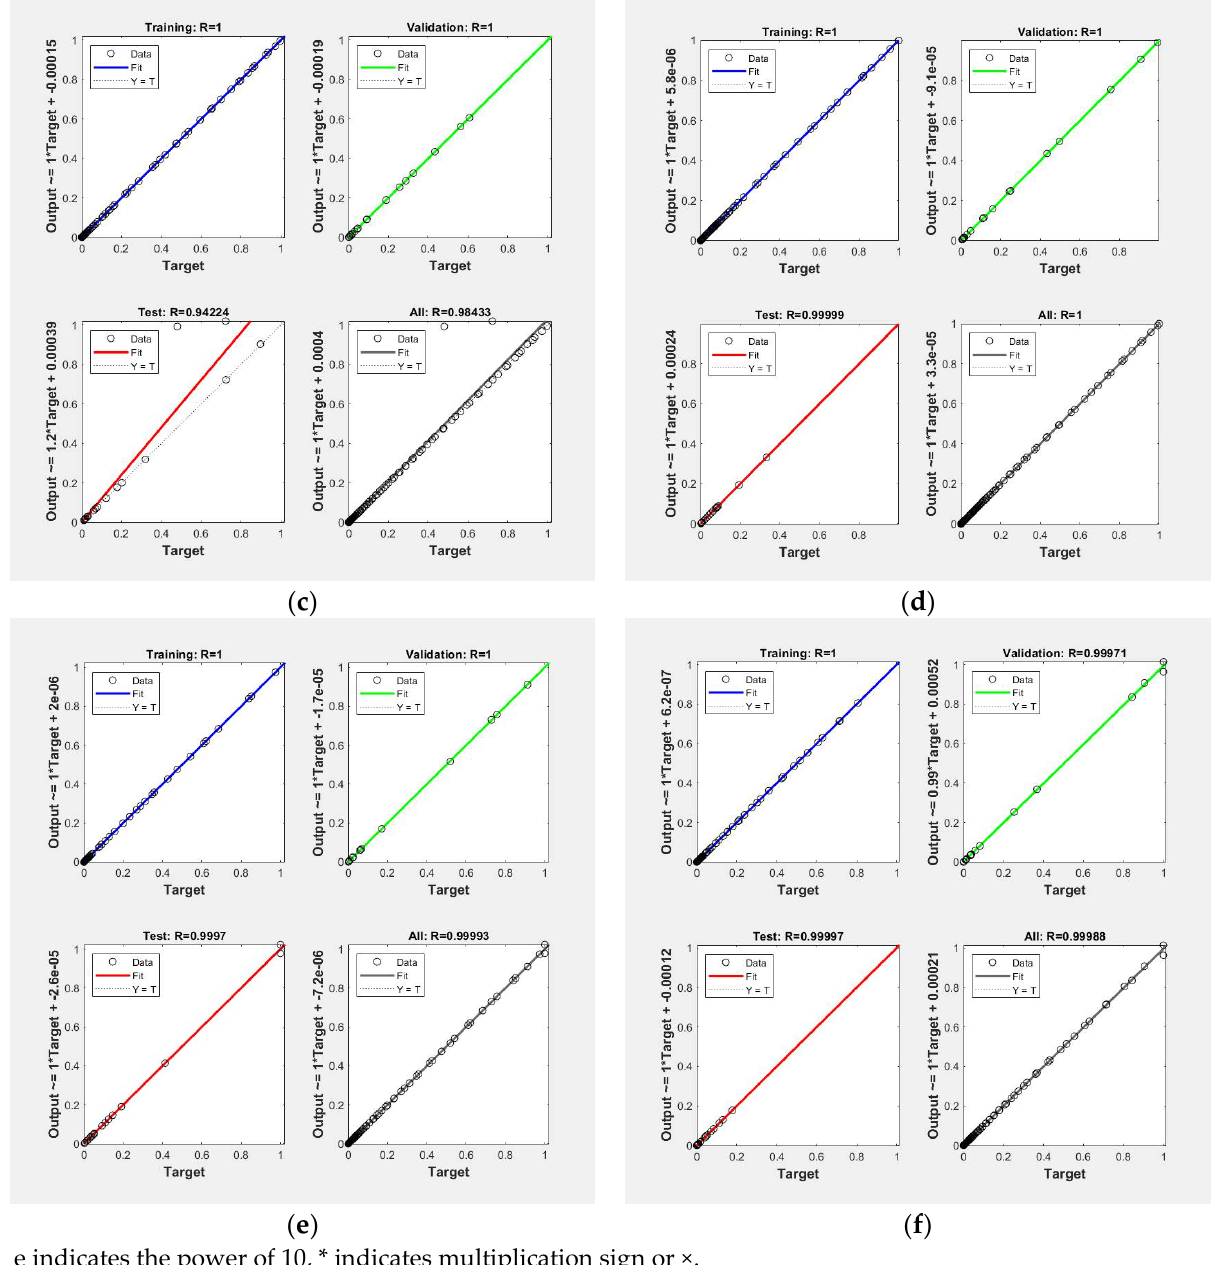
e indicates the power of 10, * indicates multiplication sign or ×. Figure 2. Regression plot of the proposed training network: ( a ) non-coated 0 h at neuron 4; ( b ) non-coated 288 h at neuron 4; ( c ) non-coated 576 h at neuron 4; ( d ) coated 0 h at neuron 6; ( e ) coated 288 h at neuron 3; ( f ) coated 576 h at neuron 4.